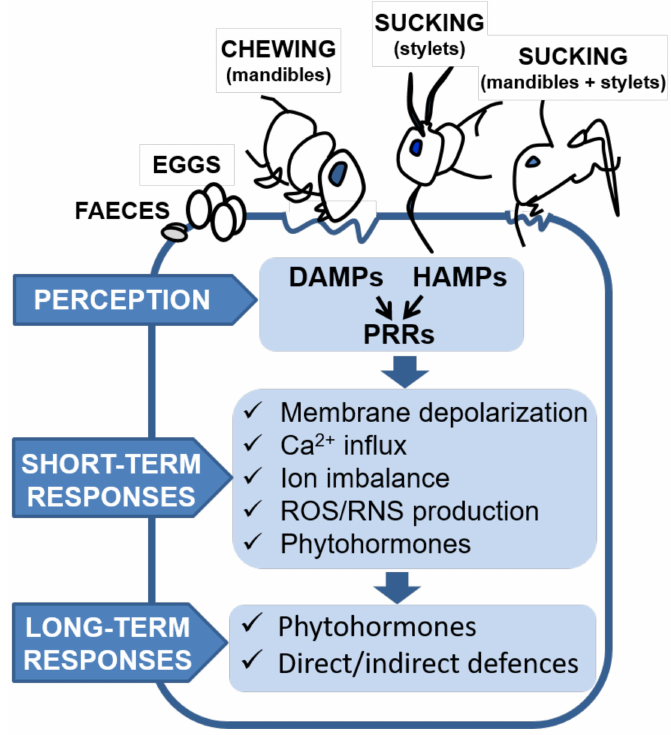
Figure 1. Early and late plant events in plant–phytophagous pest interactions. Insects and acari with different mouth structures and several feeding modes select host plants. Specific plant receptors (pattern recognition receptor, PRRs) recognize elicitors/effectors (damage-associated molecular patterns, DAMPs, and herbivore-associated molecular patterns, HAMPs) derived from either the plant or the phytophagous pest side (insects and acari) and activate downstream short-term and long-term defense responses. ROS, reactive oxygen species; RNS, reactive nitrogen